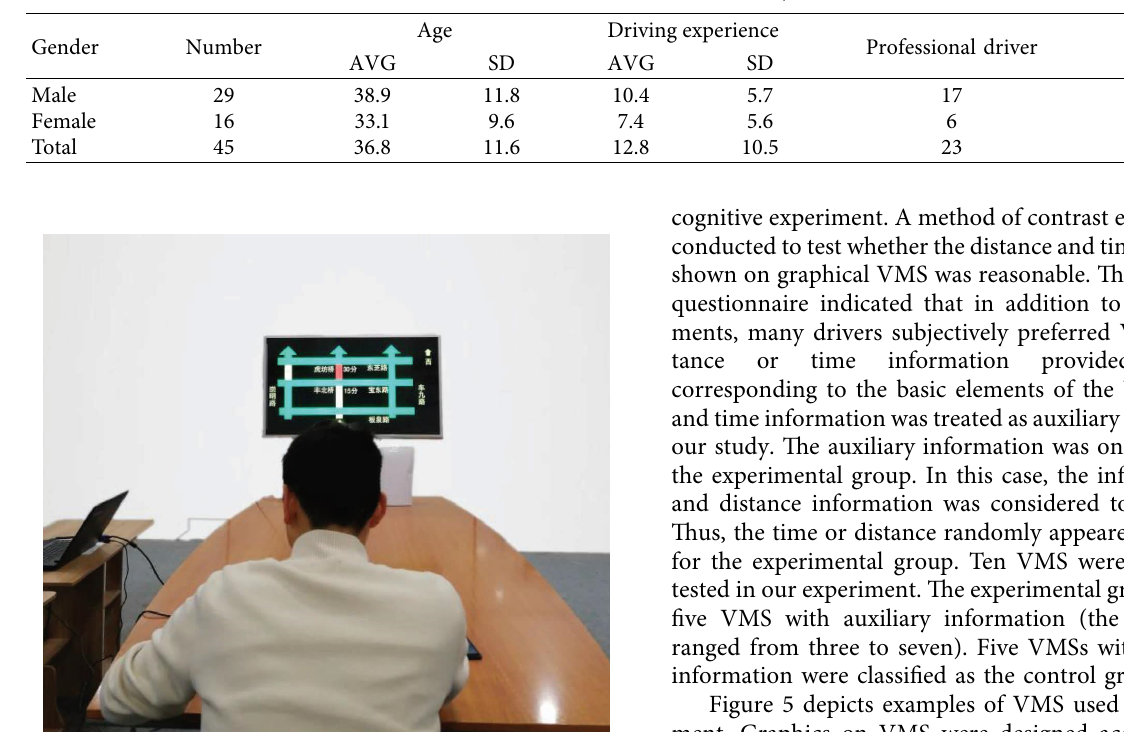
Table 1: Basic information of subjects.